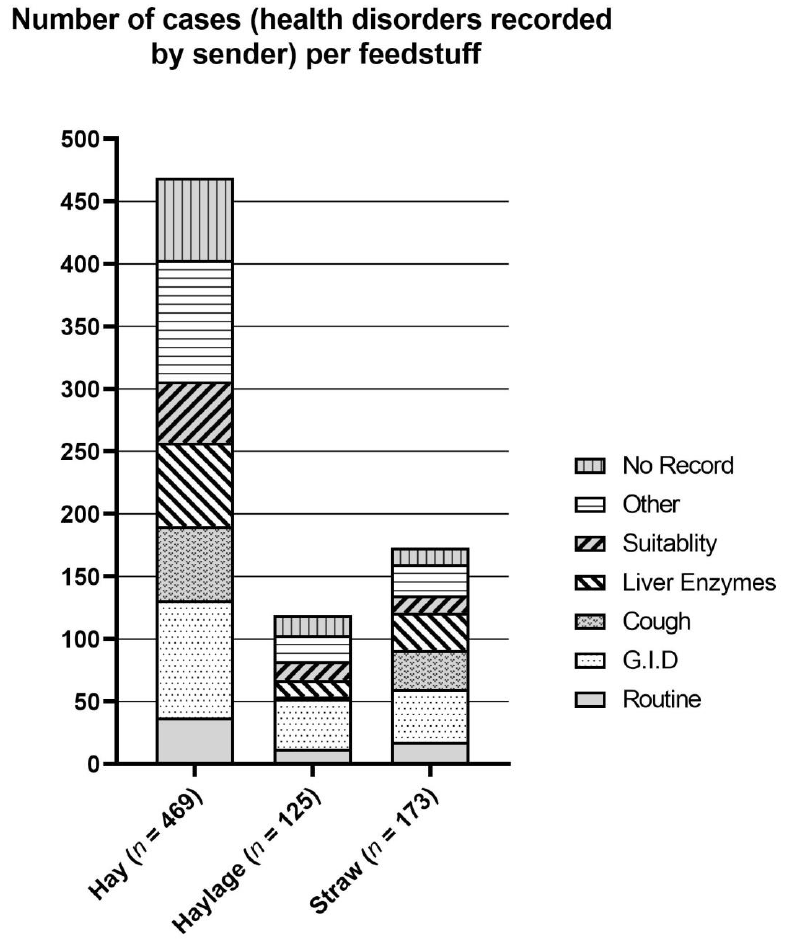
Figure 1. Anamnestic reports given for samples of hay, haylage, and straw submitted for microbi- ological examination. Other ( n = 149, all types of roughage): Allergic symptoms (30), refusal of feed (27), laminitis (15), poor performance (14), sudden death (12), cachexia (11), skin disease (4), swelling (legs) (4), intoxication symptoms (3), official control (3), abortion (3), fungal infection (3), swelling (head) (3), sterility (3), nervous disorders (2), lameness (2), sudden collapse (2), bale inflammation (1), salivation (1), cystitis (1), alteration of blood counts (1), botulism (1), Equine Cushing’s disease (1), fever (1), polyuria (1). G.I.D. = gastrointestinal disorder ( n = 195): colic (169), diarrhea (16), or watery stools